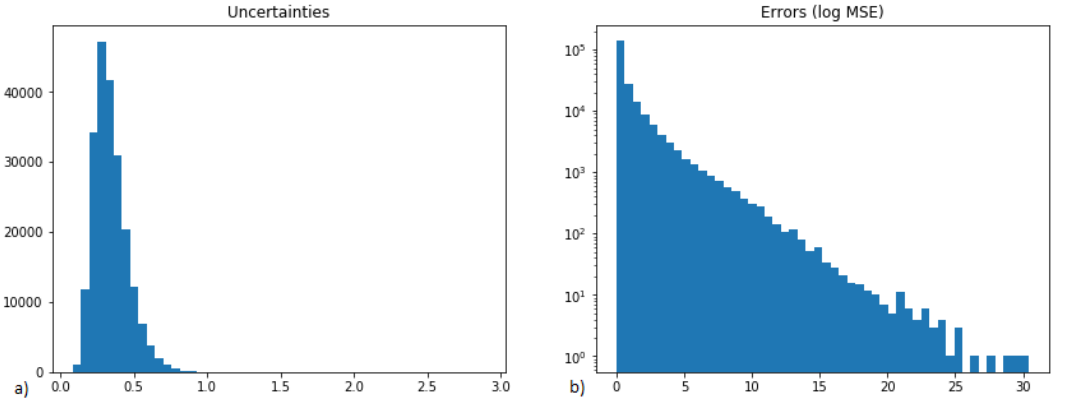
Figure 6. Analysis of uncertainty and MSE of activity prediction (calculated for all targets considered). ( a ) uncertainty ; ( b ) prediction error expressed as log(MSE) .